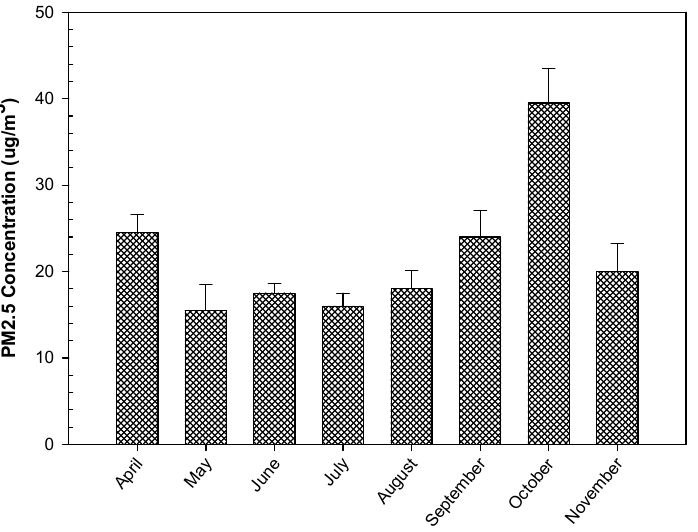
Figure 5. PM 2.5 average concentrations before a rainfall event ( µ g m − 3 ) recorded in the three monitoring points in Targovis te city in 2019 and associated error bars showing the differences between the concentrations provided by the three Rokidair microstations.